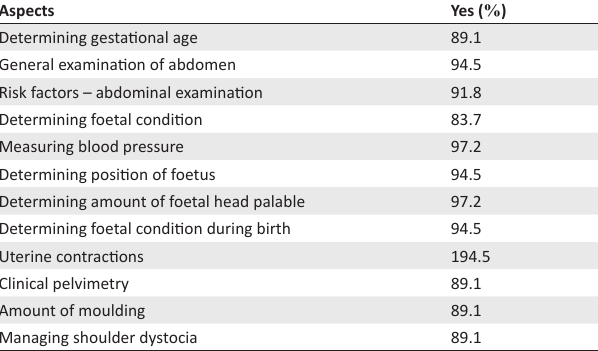
TABLE 3: Adequate coverage and facilitation of practical